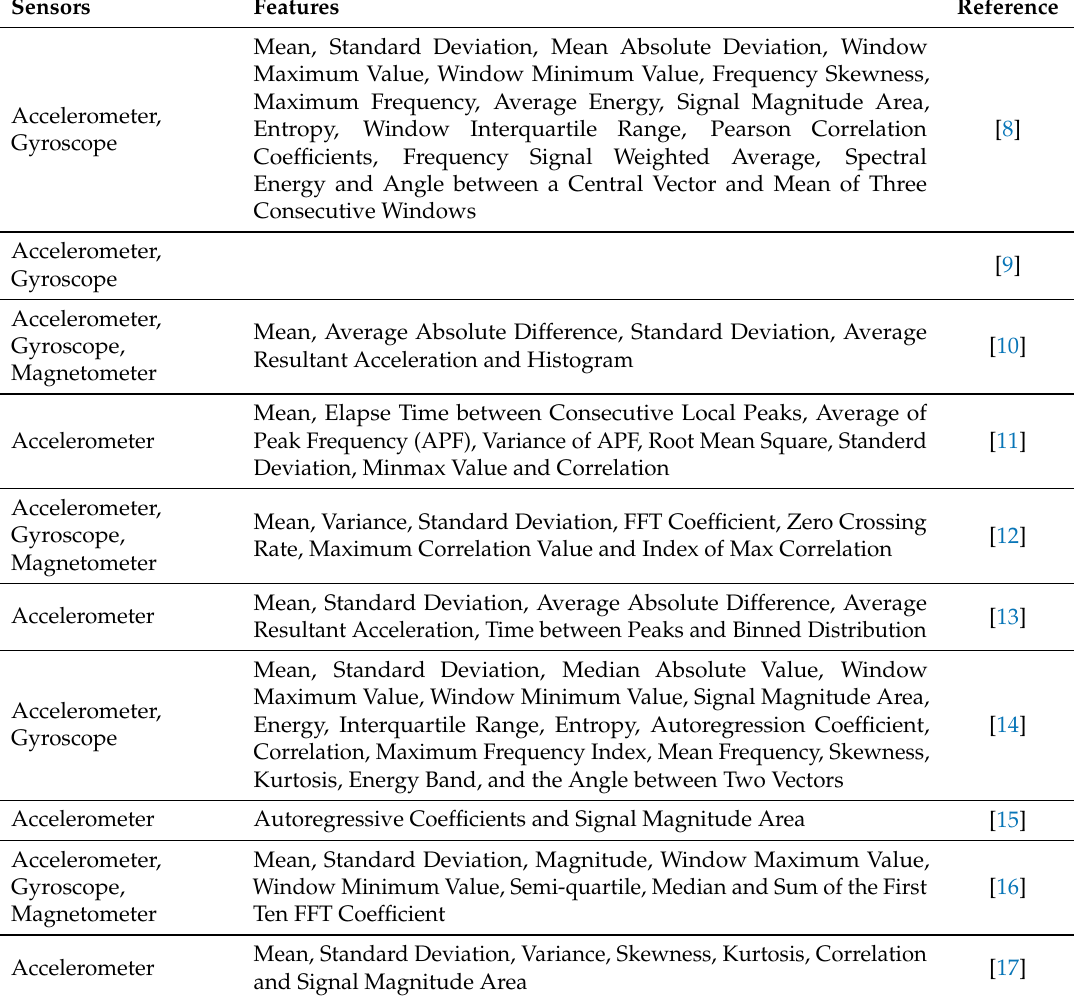
Table 1. Sensors and features used in prior research on human activity recognition with smartphones.